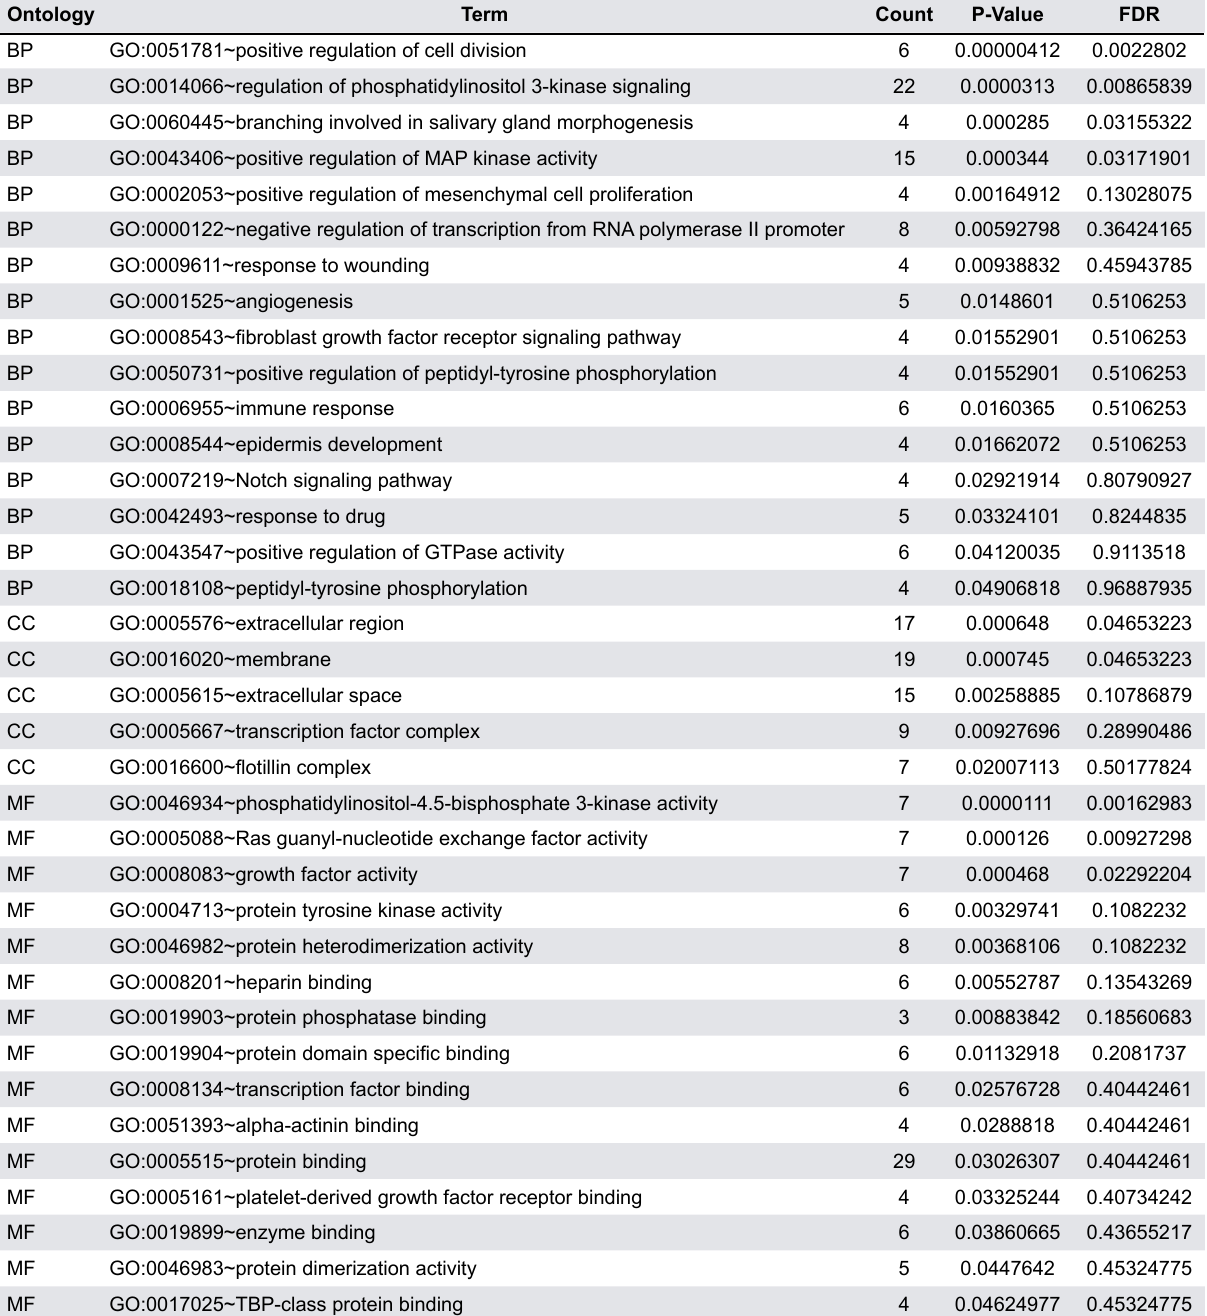
Table 1- GO analysis of differential expressed genes associated with